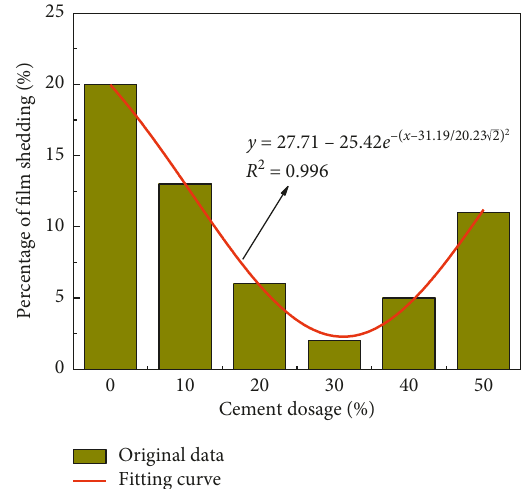
Figure 9: The relationship between the cement dosage and the percentage of film shedding.